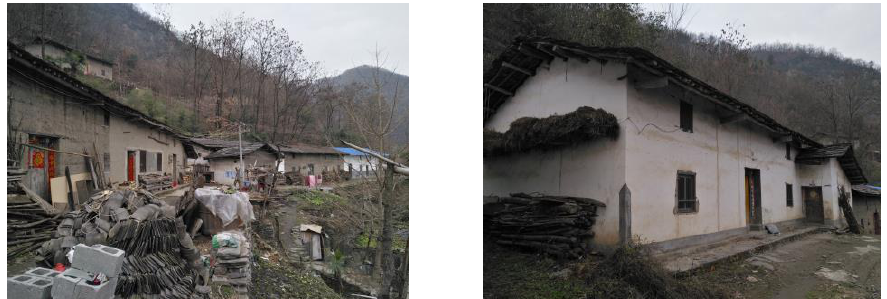
Figure 2. Photo of the present situation of folk houses in southern Shaanxi.